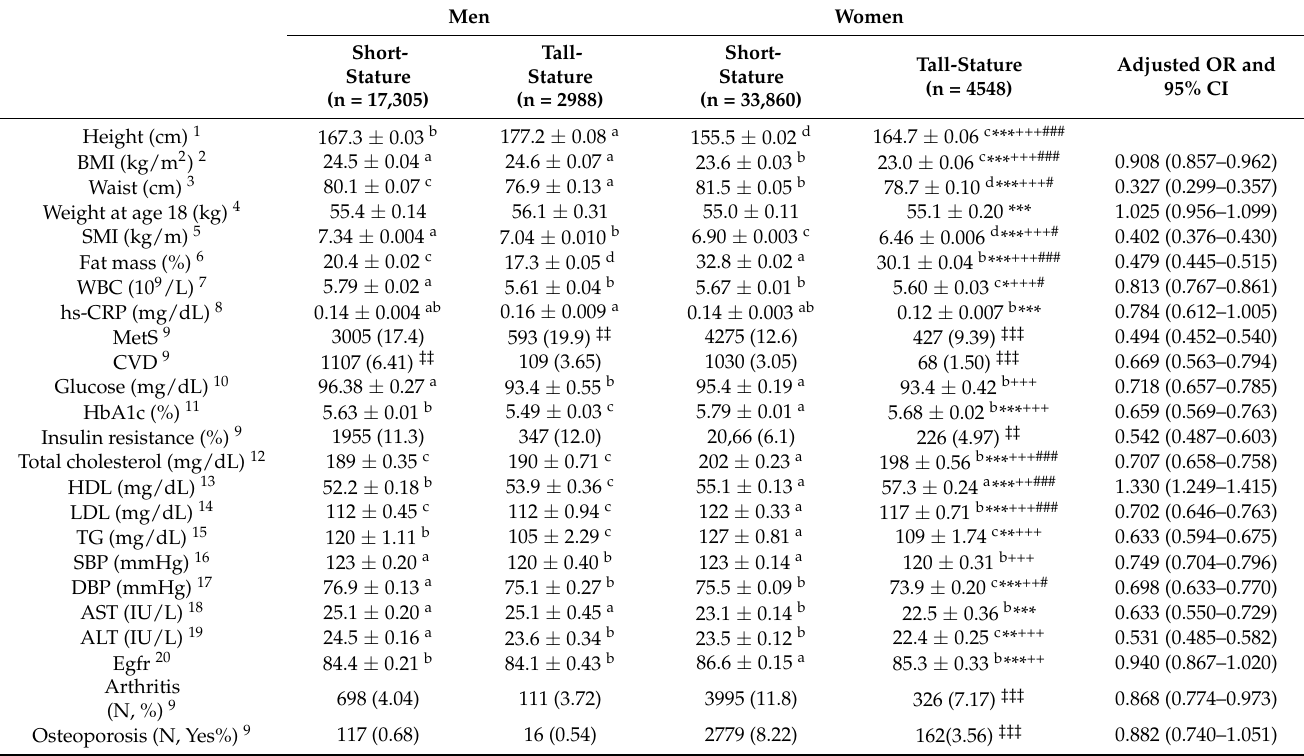
Table 2. Adjusted means and odds ratio (ORs) of metabolic syndrome-related parameters according to gender and adult